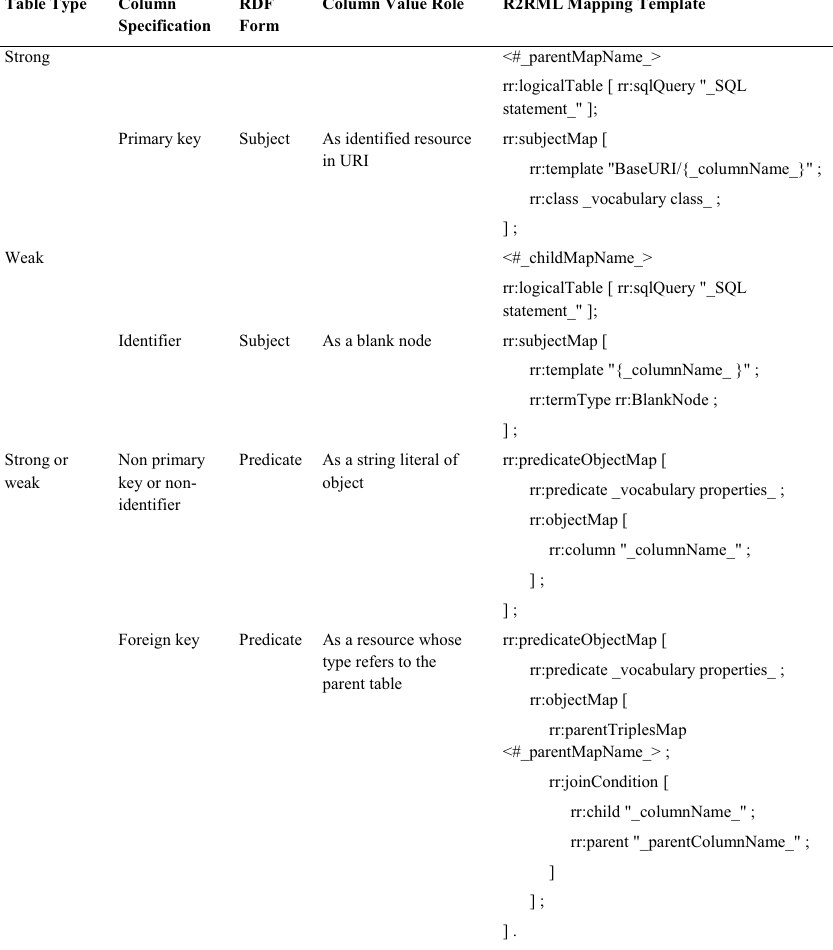
Table 2 General mapping rules Table Type Column